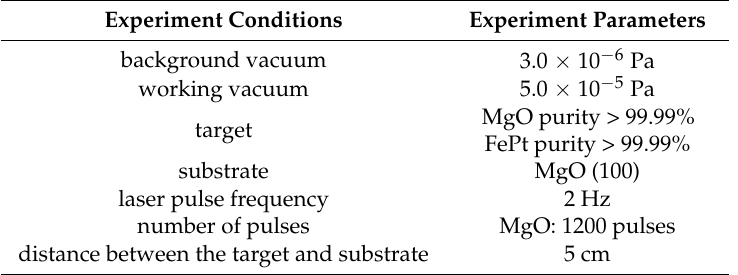
Table 1. Experimental parameters for FePt/MgO nanocomposite film